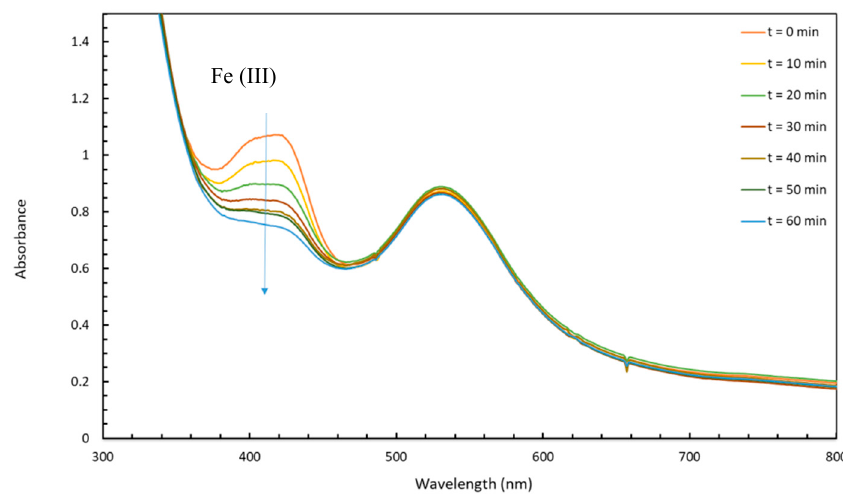
Figure 10. Temporal evolution of the UV-visible spectra of deaerated aqueous solutions containing 5 × 10 − 4 M potassium hexacyanoferrate in the presence of 15 nm Au-NPs@pNTP under LED irradiation at 520 nm (Optical path length: 1 cm).